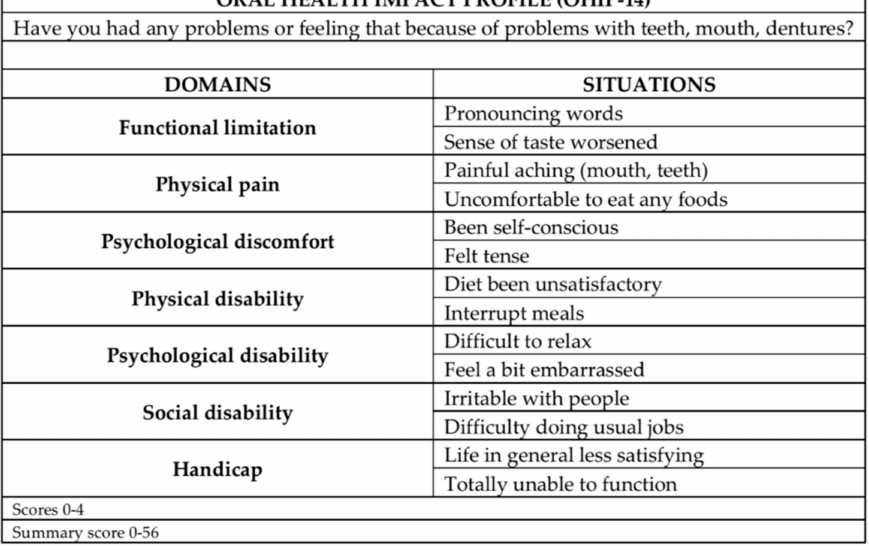
Figure 2. Oral Health Impact Profile-14